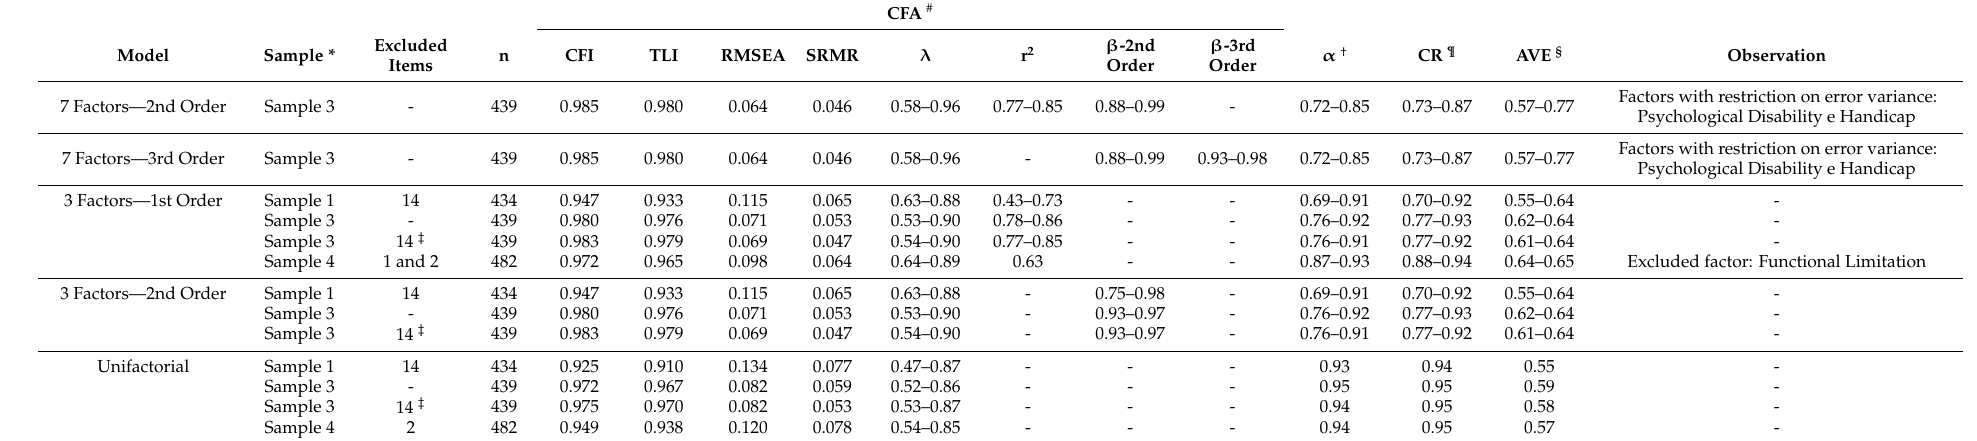
Table 3. Fit of factorial models of the Oral Health Impact Profile-14 to data from different